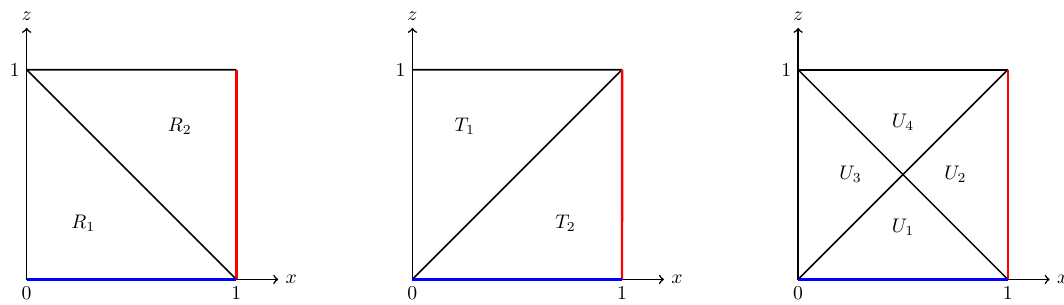
Figure 1 . Kinematic regions in the ( x, z ) -plane relevant for the analytic continuation of the box master integrals. The kinematic endpoints are z = 0 (blue line) and x = 1 (red line). two